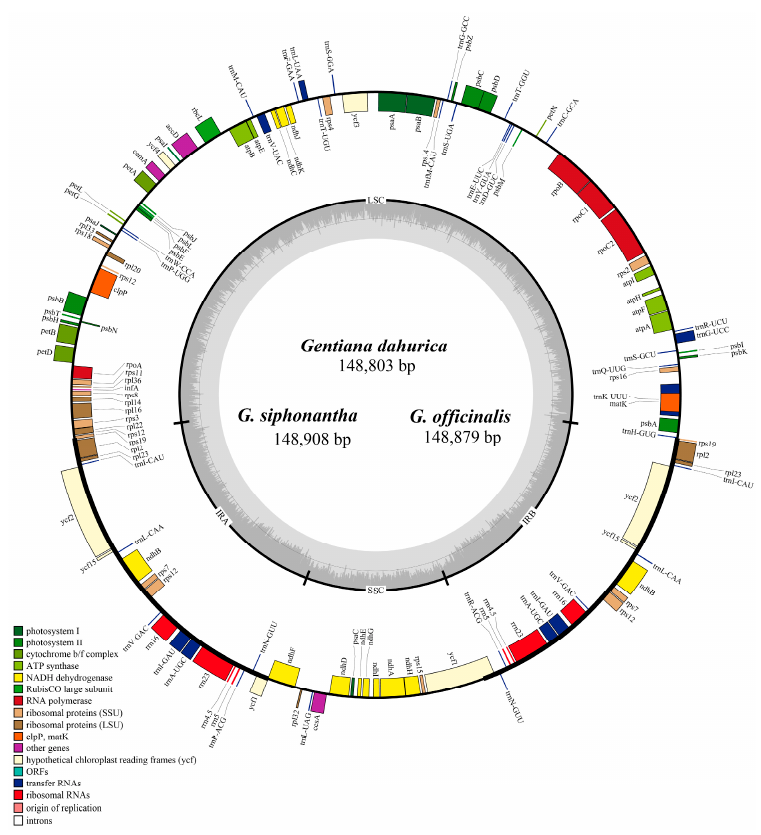
Figure 1. Merged gene map of the complete chloroplast genomes of three Gentiana species. Genes belonging to different functional groups are classified by different colors. The genes drawn outside of the circle are transcribed counterclockwise, while those inside are clockwise. Dashed area in the inner circle represent GC content of chloroplast genome.